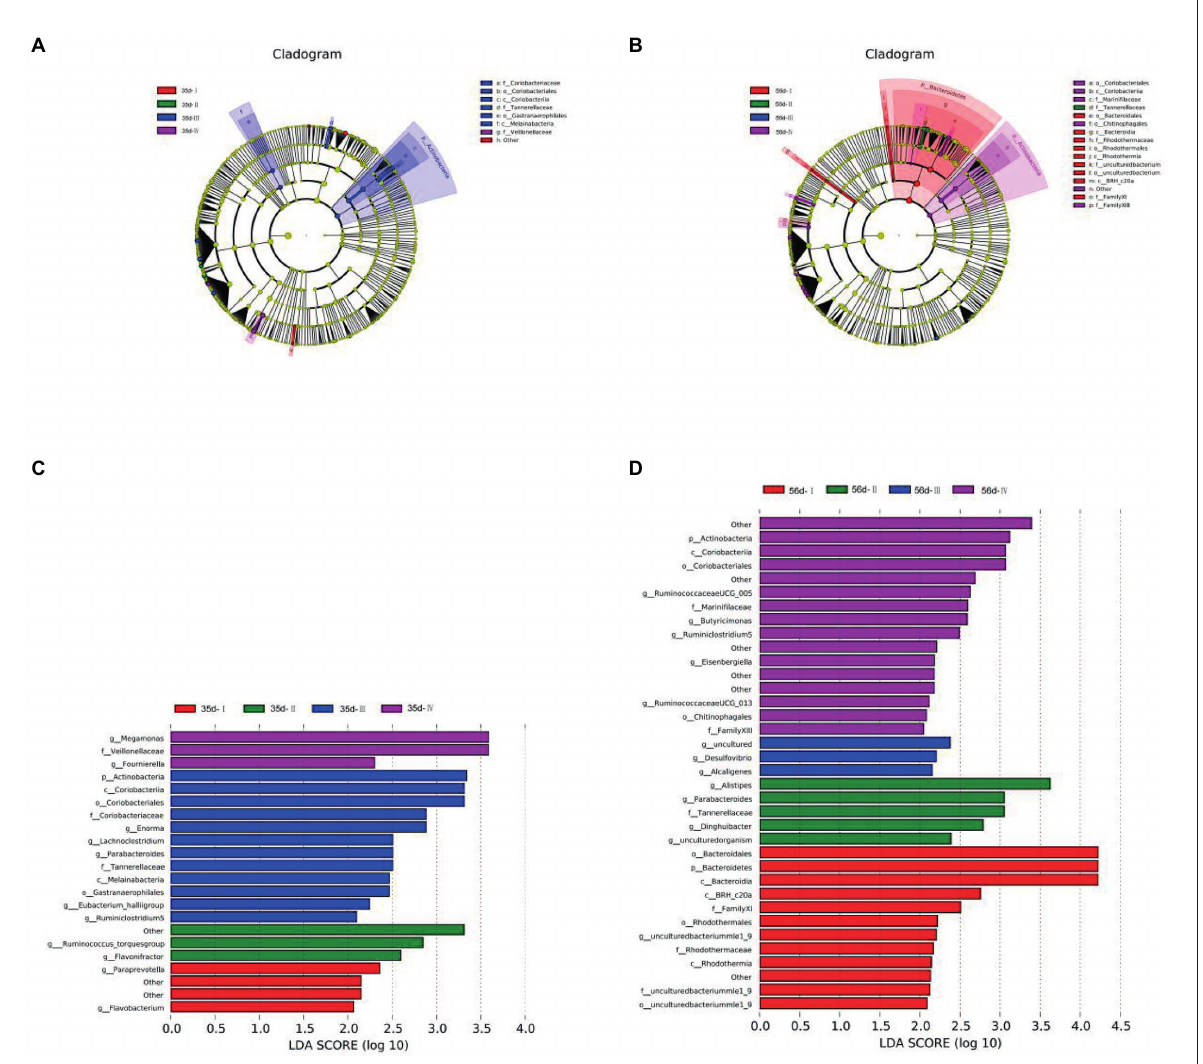
FIGURE 6 Differential microbial LEfSe analysis and LDA score chart of the cecum of broilers in different treatment groups. (A) LEfSe analysis of 35-day-old broilers; (B) LEfSe analysis of 56-day-old broilers; (C) LDA score chart of 35-day-old broilers; (D) LDA score chart of 56-day-old broilers. LEfSe analysis was used to determine the phylogenetic characteristics of specific bacterial taxa and major bacteria in three different groups. Biomarker taxa are highlighted by colored circles and shaded areas. The diameter of each circle is related to the abundance of taxa in the